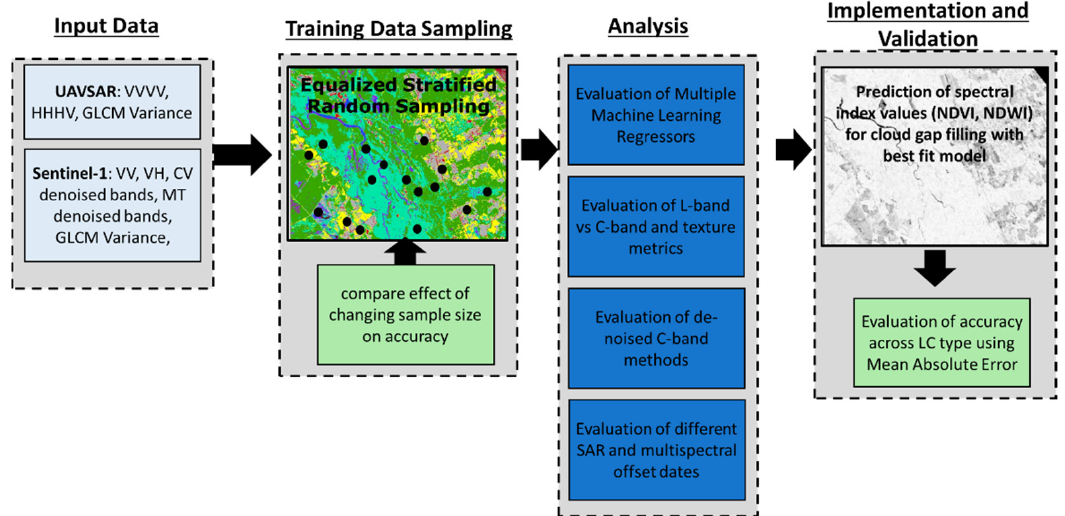
Figure 2. Simplified overview of the study. The graphic shows the SAR datasets that were evaluated, how training and validation data for the machine learning models was obtained and the different analyses that were conducted for predicting the spectral index values for cloud-obscured pixels.